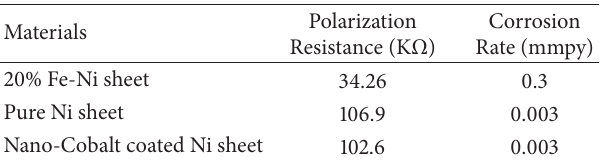
Table 2: Comparison of polarization resistance and corrosion rate of three samples after corrosion tests in 0.1M NaCl